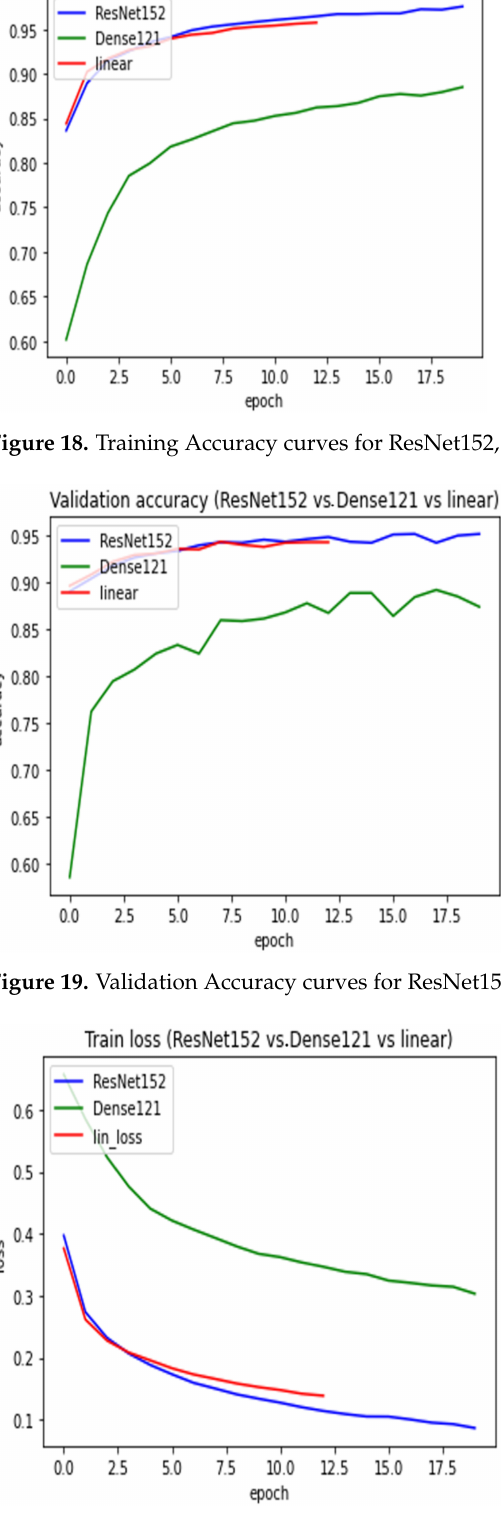
Figure 20. Training Loss curves for ResNet152, Dense121, and linear